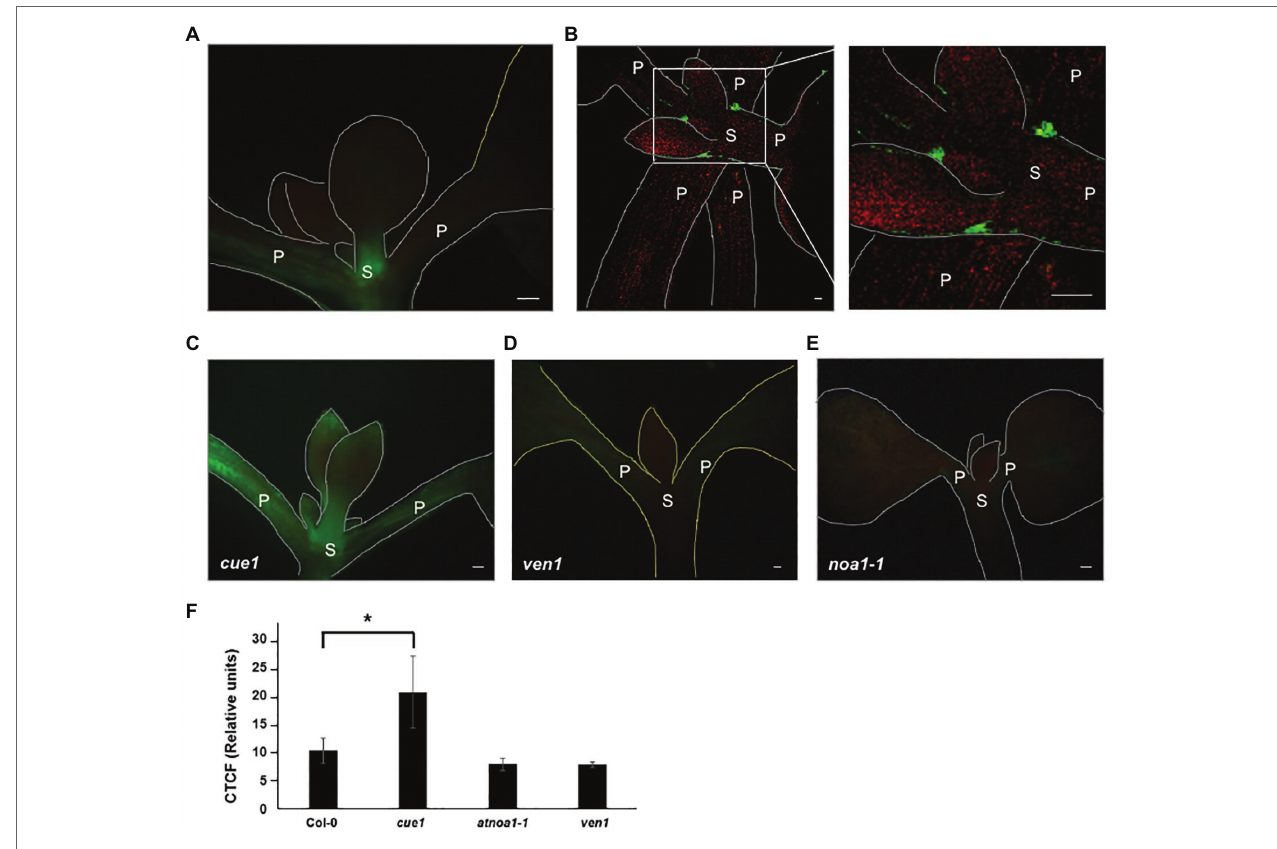
FIGURE 1 | Endogenous nitric oxide (NO) levels in Arabidopsis thaliana young leaves. Detection of endogenous NO production using 4,5-diamino-fluorescein diacetate (DAF-2DA) in Columbia-0 (Col-0; A,B ), cue1/nox1 (C) , ven1 (D) , and NO-ASSOCIATED 1 ( noa1-1 ; E ) between 7- and 15-day-old seedling leaves observed with LEICA MZ 16 FA microscope coupled to with a LEICA DFC 490 digital camera (A,C–E) and with a Leica TCS SP2 confocal microscope (B) . Quantitative data of NO-dependent DAF-2DA fluorescence leaf images. Values represent the mean ± SE ( n = 15). Asterisk indicates statistically significant difference compared to Col-0 ( t -test, * p < 0.05; F ). Scale bars, 50 μ m. P, petiole; S,